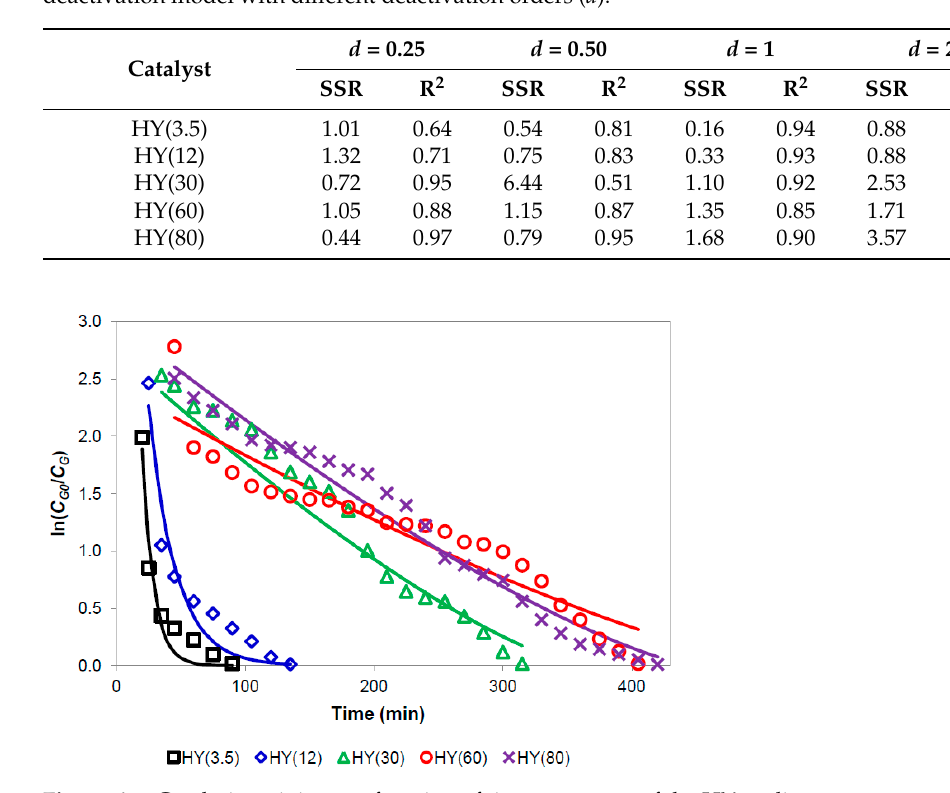
Table A2. Values of the sum of square residuals (SSR) and determination coefficient (R 2 ) for each deactivation model with different deactivation orders ( d ).